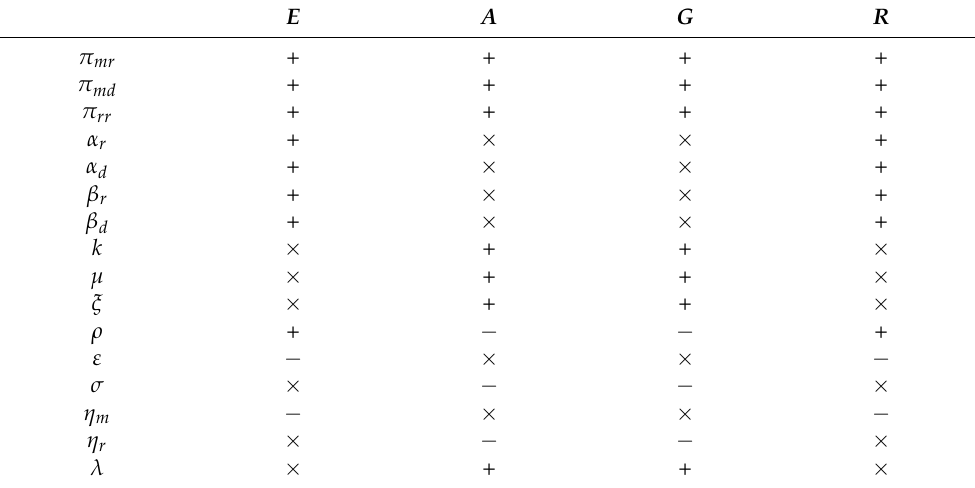
Table 4. Comparative static analysis of parameters under the centralized decision